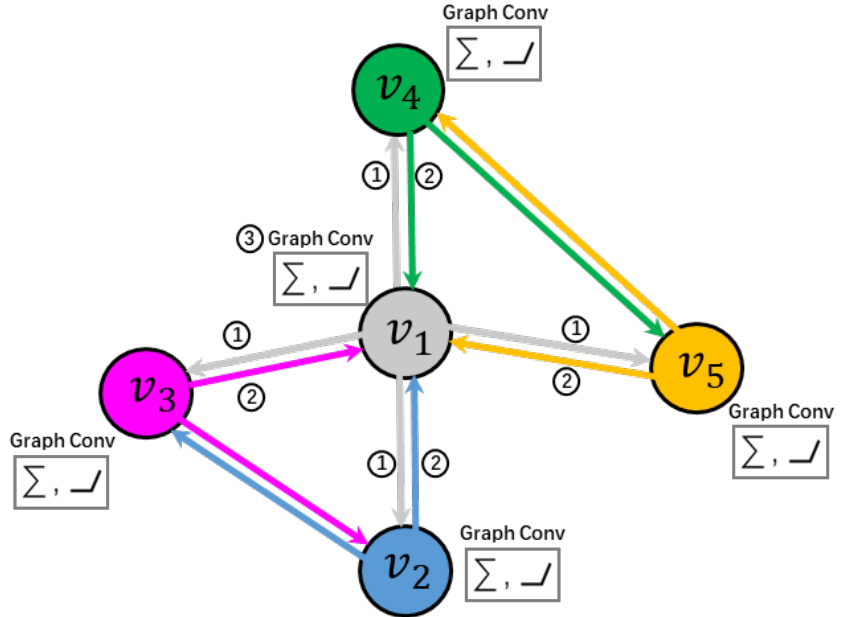
Figure 4. Visual example of the three steps in the graph convolution of GCN: information broadcasting , information collection and information aggregation. For example, node 𝑣 1 broadcasts its feature to its neighboring nodes 𝑣 2 , 𝑣 3 , 𝑣 4 and 𝑣 5 at first. Second, node 𝑣 2 collects features from node 𝑣 2 , 𝑣 3 , 𝑣 4 and 𝑣 5 . Third, aggregate information by gathering and activating nonlinearly the fusion features.